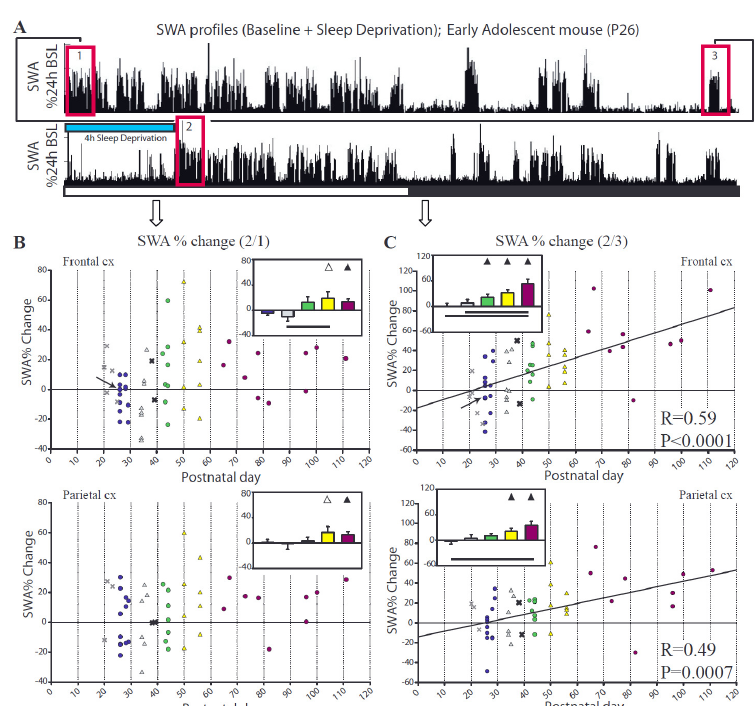
Figure 6. Change in NREM SWA after sleep deprivation. Each faint “X” denotes a mouse that underwent a 2 h deprivation and is included only as a reference. p and R correspond to the regression line computed from all animals except those denoted by a faint “X”. ( A ) shows changes in relative SWA for the frontal derivation in a representative adolescent (P26) mouse (indicated by an arrow in B , C ). Boxes 1,2,3 indicate the first hour of baseline sleep during the light period, the first hour of recovery sleep after sleep deprivation, and the last hour of baseline sleep at night, respectively. The ratios 2/1 and 2/3 were used for the analysis shown in ( B , C ). Bars show differences between groups (Tukey’s HSD), and triangles indicate group means different from 0 (one sample, 2-tailed t -test; filled symbols p < 0.05, empty symbols p <